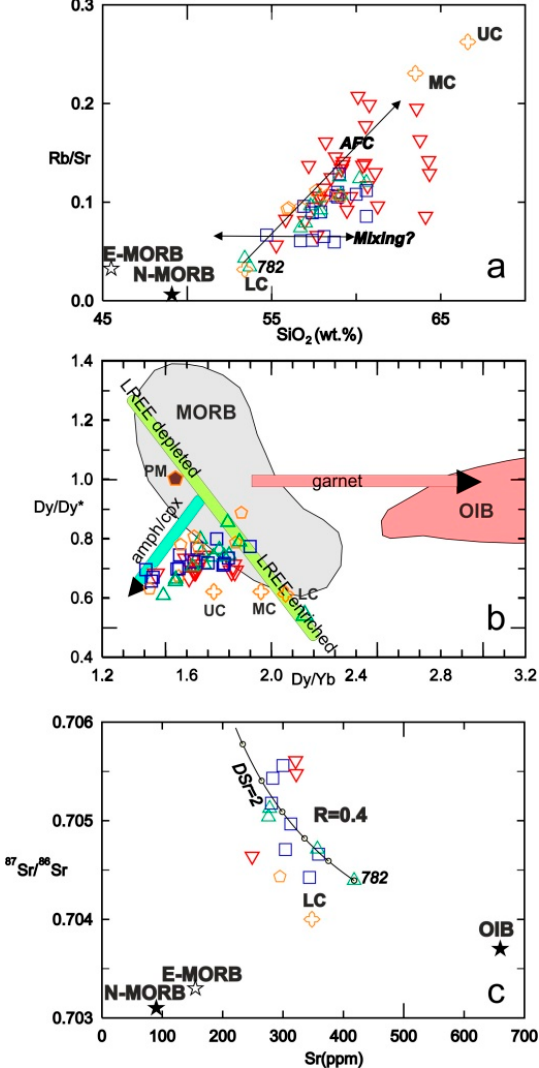
Figure 13. ( a ) SiO 2 vs. Rb/Sr for the Miocene magmatic rocks of Bont ă u volcano rock; LC-Lower crust; MC-Middle crust; UC-Upper crust after [57]; NMORB (black star) after [49]. Red triangles of the Groups 1-Z from [3]; ( b ) Plot of Dy/Dy* vs. Dy/Yb [58] to show fields for MORB and OIB, PM (primitive mantle) [49]; Vectors for mineral control and melting are indicative of amphibole and clinopyroxene via decrease of Dy/Dy*, and Dy/Yb also similar for the typical calc-alkaline rocks in the Bont ă u volcano that as well suggest a linear trend from MORB at higher Dy/Dy* to lower Dy/Yb. Red triangles are plots of previous data for the Bont ă u volcano [20]; [41]; ( c ) 87 Sr/ 86 Sr vs. Sr assimilation-fractional crystallization (AFC) modeling using [59] software starting from the most primitive basaltic andesite (sample782). Symbols and source of the data as in Figure 9. Red triangles of Groups 1-Z from [3].